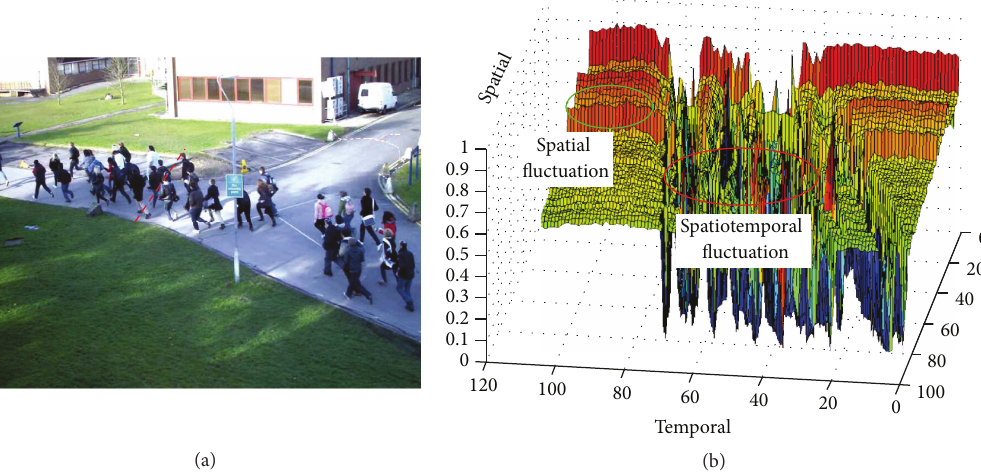
Figure 3: Fluctuation of video signal in spatiotemporal domain. (a) Original crowd image, in which we marked a cross line with red dots to investigate the fluctuation. (b) Fluctuations at the corresponding cross line in spatiotemporal domains, where the green circle indicates variations at background pixels in spatial domain and the red circles indicated fluctuations for moving crowd in both spatial and temporal